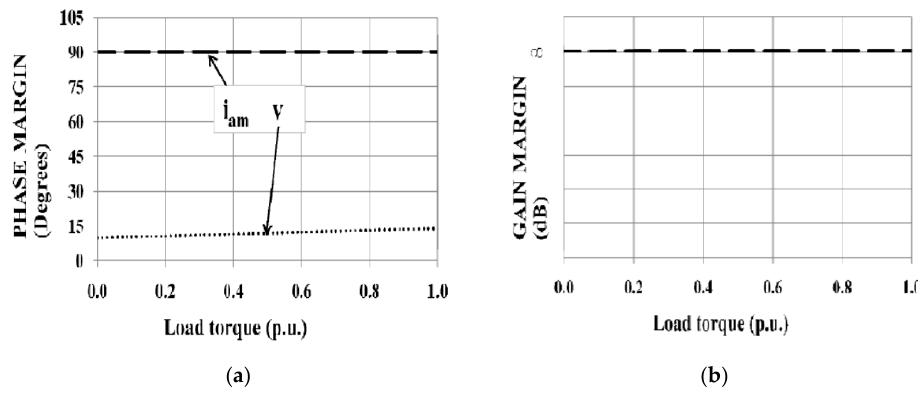
Figure 10. Sensitivity analysis of v and i am .( a ). Phase margin ( b ). Gain margin (both v and i am ).